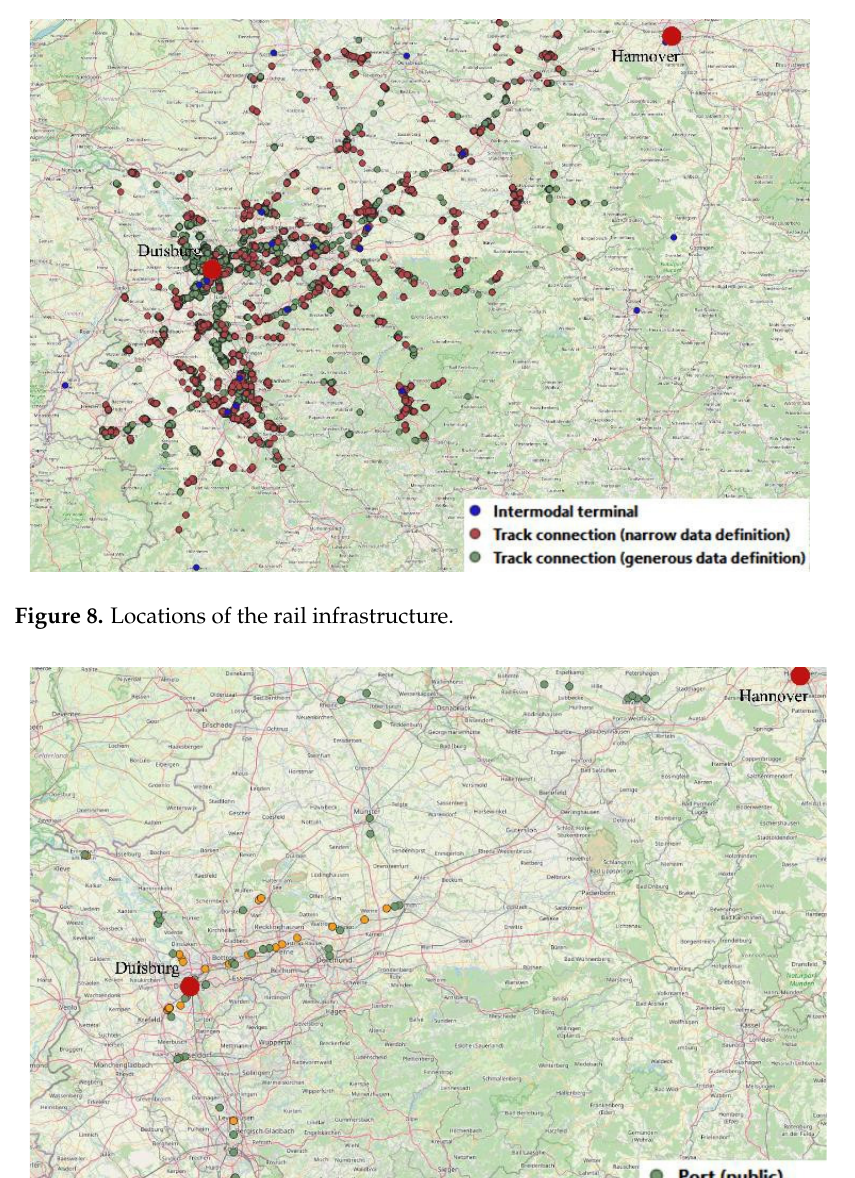
Figure 7. Locations of the highway junctions.